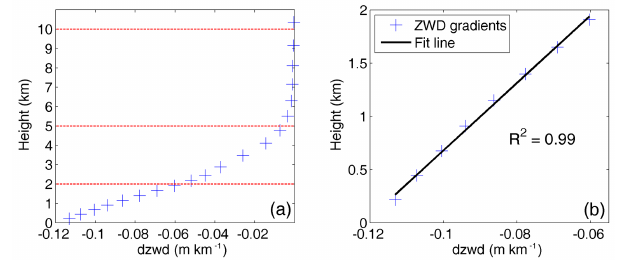
Figure 2. ZWD vertical gradients profile (a) and linear fit with height below 2km (b) at a grid point (0 ◦ N, 0 ◦ E) at 12:00UTC on 1 January 2010.